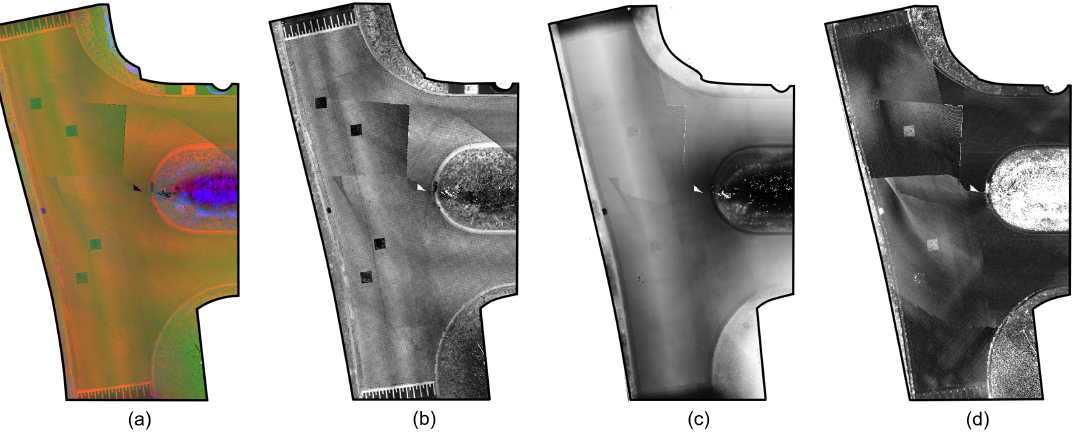
Figure 4. Example of an IHV (intensity, height, variance) image ( a ) shown as an RGB image and the different channels, intensity ( b ), minimum height ( c ) and height variance ( d ), as gray images. Notice how the intensity and height variance channels indicate sudden changes at the intersection caused by overlap of point cloud segment of different